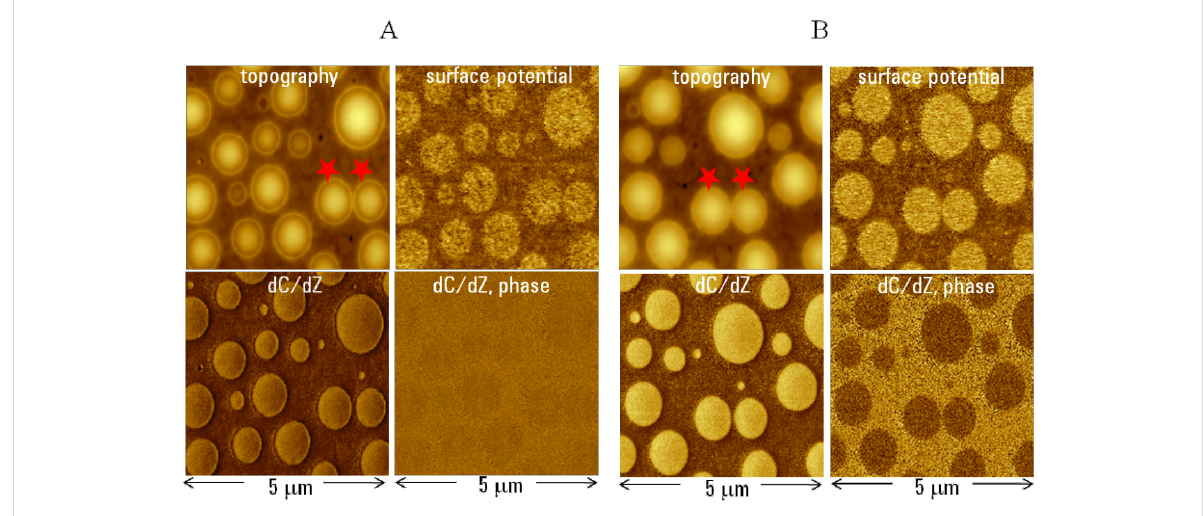
Figure 10: Topography, surface potential and d C /d Z (amplitude and phase) images of 80 nm thick film of PVAC/PS blend on ITO glass. The images in A were obtained in air and the images in B in high humidity (RH = 95%). The contrast covers height corrugations in the 0–35 nm range, surface potential variations in 0–0.6 V range, d C /d Z amplitude alternations in the 0–180 mV range and d C /d Z phase changes in the 0–20 degrees range in both sets of the